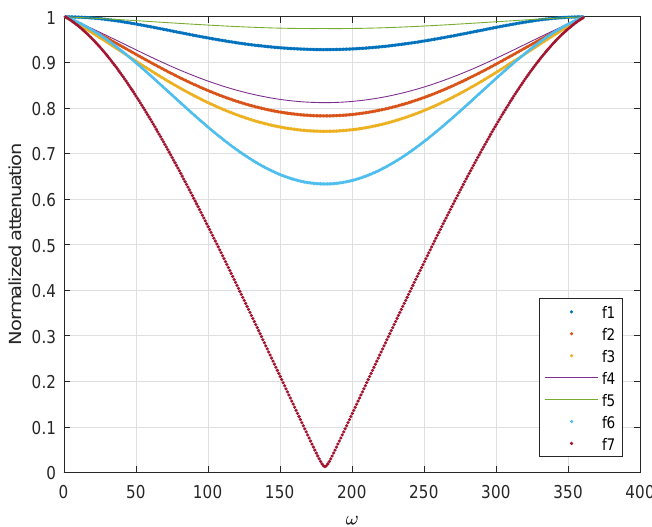
Figure 8. Attenuation of different frequencies in different